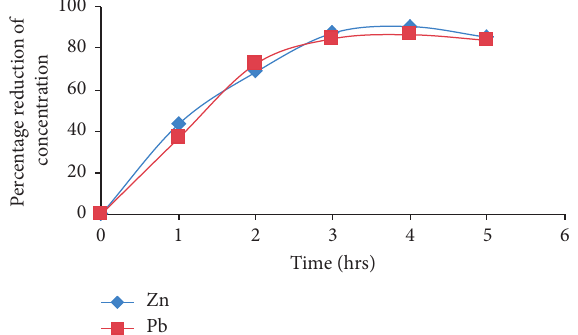
Figure 7: Effect of 1.0 g mass of ZSM-11 on the removal of Pb 2+ and Zn 2+ from aqueous solutions.